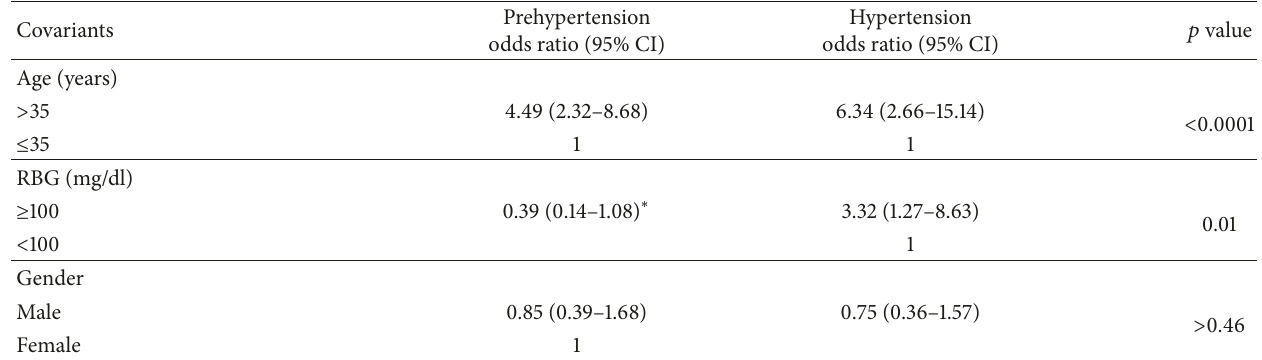
Figure 2: Scatter plots showing the distribution of systolic (a) ( 𝑟 = 0.48 , 𝑝 < 0.0001 ) and diastolic (b) blood pressure with age in the study cohort ( 𝑟 = 0.36 , 𝑝 < 0.0001 ). Table 1: Risk assessment of prehypertension and hypertension in the cohort.